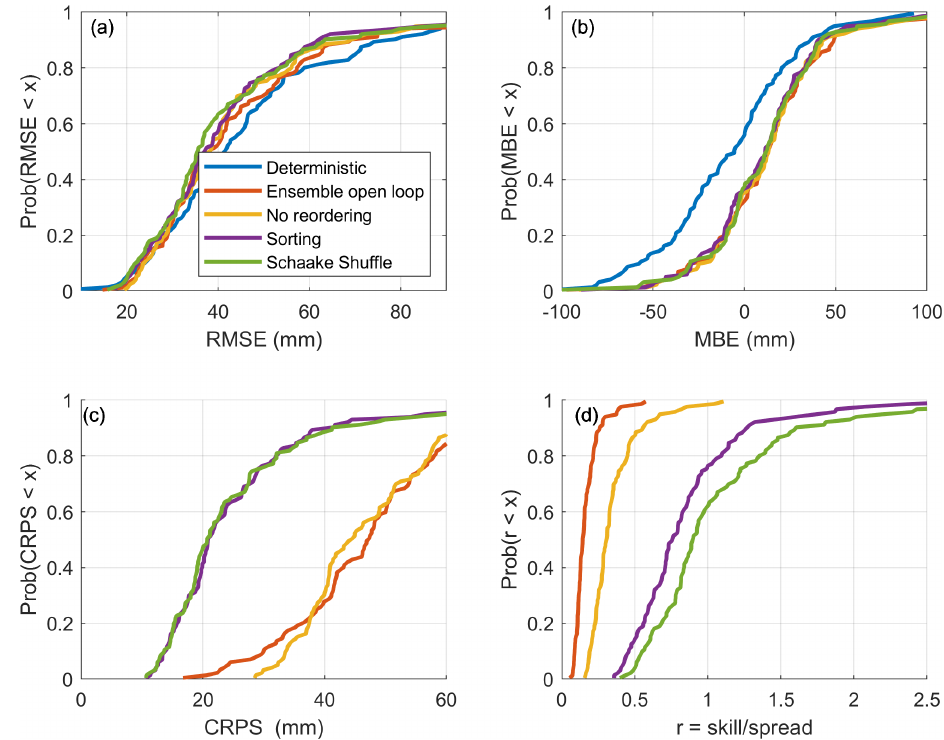
Figure 8. Cumulative distributions of the scores calculated for the 50% validation snow courses.